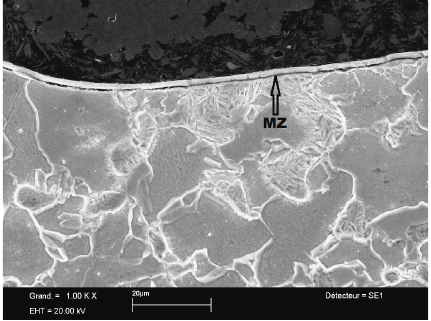
Figure 12: Measuring of MZ